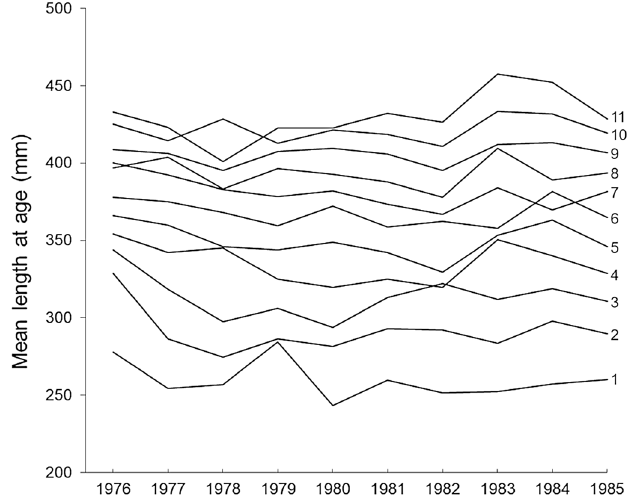
Fig. 8. Mean total length of Pagrus pagrus sampled in southern Brazil at ages 1 to 11 in the years 1976 to 1985 ( n =4